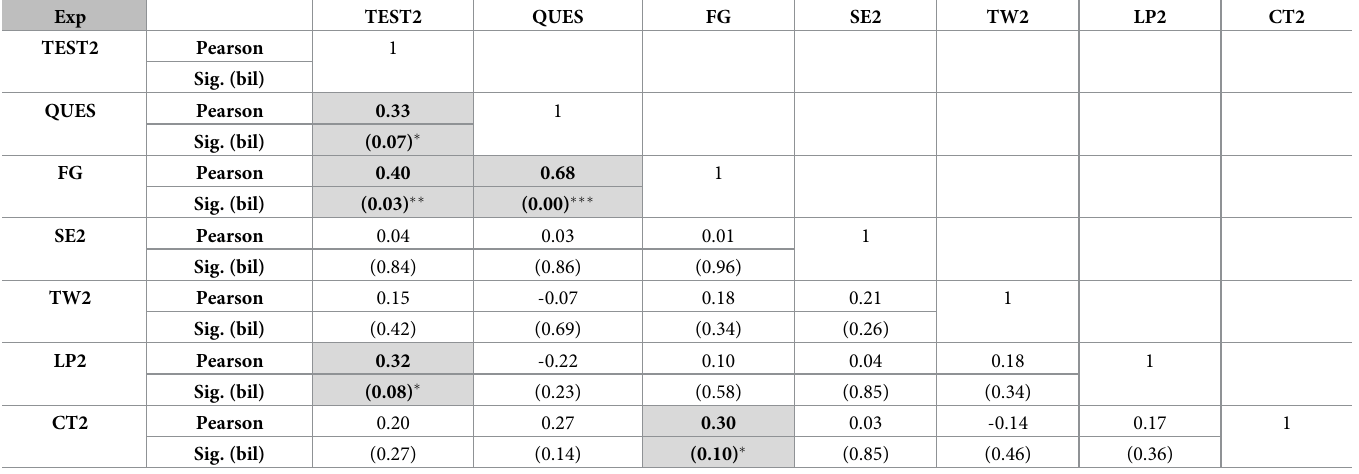
Table 8. Pearson correlations: Experimental group after the experiment.